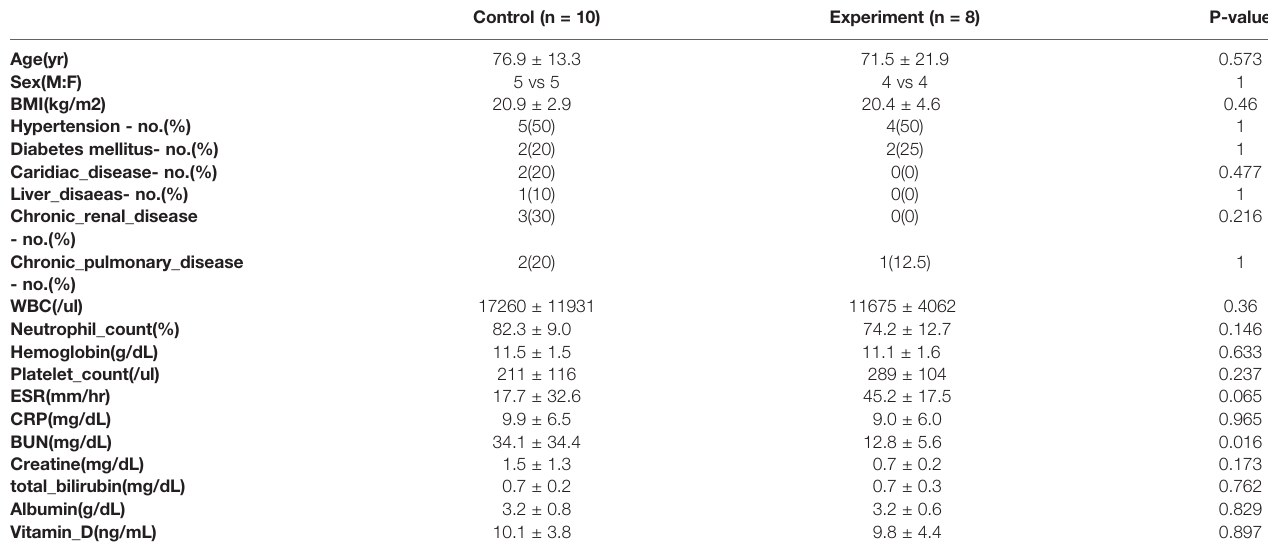
TABLE 1 | Demographic and clinical characteristics of study population